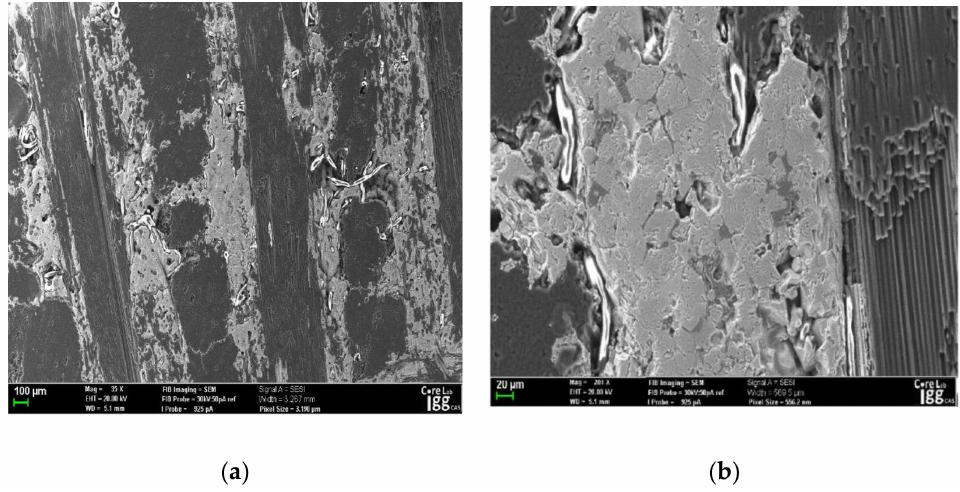
Figure 2. Typical SEM micrographs of the Cf / C-TiC composite ( a ) 21 × . ( b ) 2000 ×